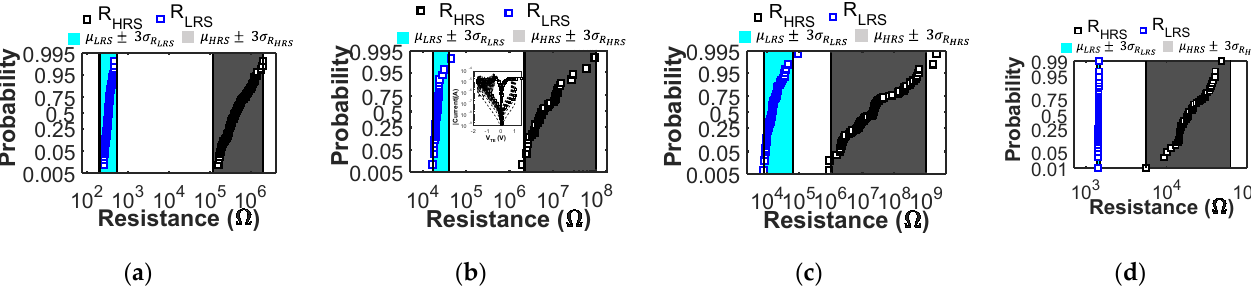
Figure 2. Probability plots showing the experimental (cyan and grey bands) and simulated (blue and black squares) cycle to cycle variability. Cyan and grey areas indicate the range µ ± 3𝜎 of the experimental LRS and HRS distributions. For each technology, the simulations replicate the available experimental conditions, and the reset and set voltages are reported. Specifically, ( a ) reports the variability obtained with technology 1 under quasi-static DC conditions (simulation variability parameters σ x = 0.35 nm, σ S = 2.7 nm 2 ). Data from [26]; ( b ) reports the variability obtained with technology 2 under quasi-static DC conditions and I C = 20 µA, as for this technology experimental variability data [28] are available only at I C = 20 µ A (variability parameters σ x = 0.8 nm, σ S = 24.9 nm 2 ). The inset shows the experimental (square symbols) and simulated (lines) DC IV curves, where only k cf ( k cf 20 µ A = k cf 200 µ A /100), k ex ( k ex 20 µ A = k ex 200 µ A /10), and S ( S 20 µ A = S 200 µ A /10) parameters were changed to account for the different characteristic of the very narrow CF obtained with such low current compliance; ( c ) reports the variability obtained with technology 3 [29] under quasi-static DC conditions (variability parameters σ x = 0.81 nm, σ S = 0.7785 nm 2 ); ( d ) reports the variability experimentally measured on technology 4. HRS variability data are obtained using 10 µ s reset voltage pulses, while LRS data with a quasi-static positive voltage ramp as this was the only way to provide an accurate current compliance with our test setup. (Variability parameters σ x = 0.7 nm, 2 σ S = 0.350 nm